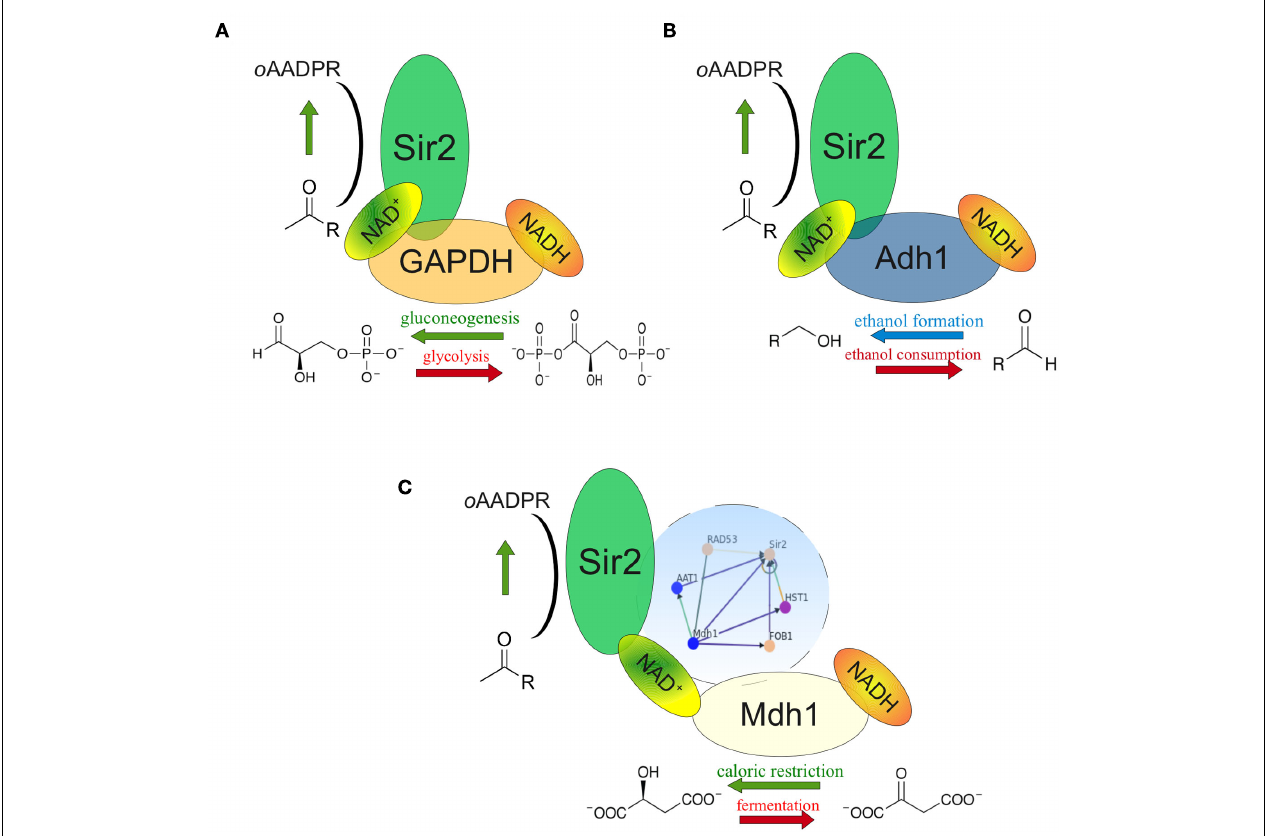
FIGURE 2 | NAD + feeding or depletion in the Sir2 microenvironment. (A) The NAD(H) metabolizing glycolytic enzyme GAPDH (Tdh3) is found in the same protein complex as Sir2. At high glycolytic flux, GAPDH deprives NAD + in close proximity to Sir2; during gluconeogenesis it generates NAD + . Genetic interplay ofTdh3 and Sir2 influences the rate of mitotic recombination. (B) The predominant cytoplasmic alcohol dehydrogenase (Adh11) also complexes with Sir2. Adh1 overexpression increased the